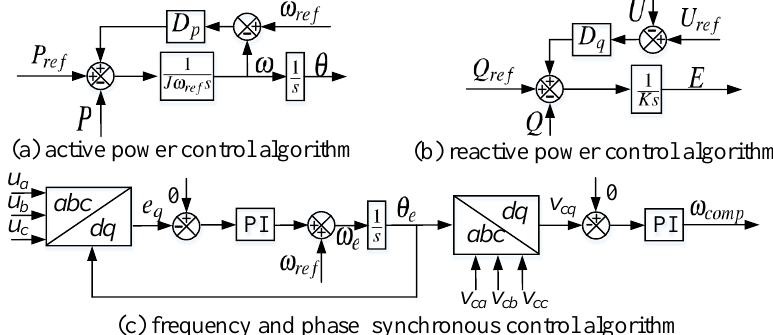
Figure 13. Control algorithm of the renewable energy interface: ( a ) active power control algorithm; ( b ) reactive power control algorithm; ( c ) frequency and phase synchronous control